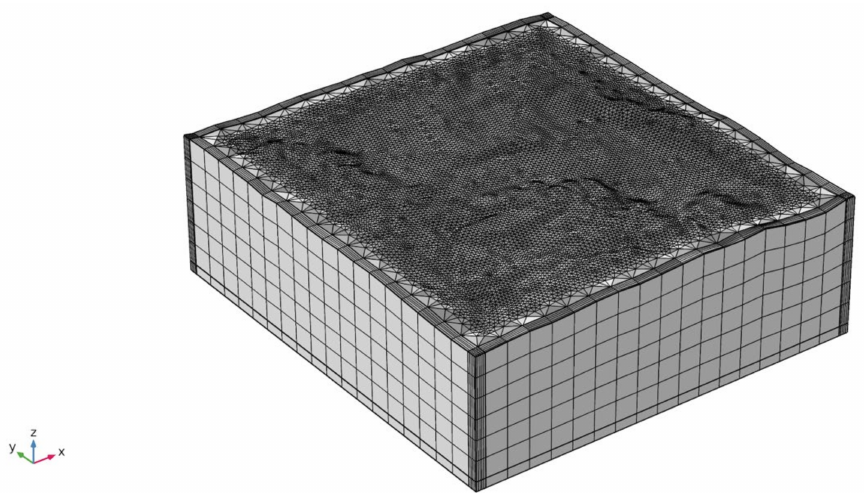
Figure 3. Domain mesh (example with rock domain and topography). The top surface is refined to